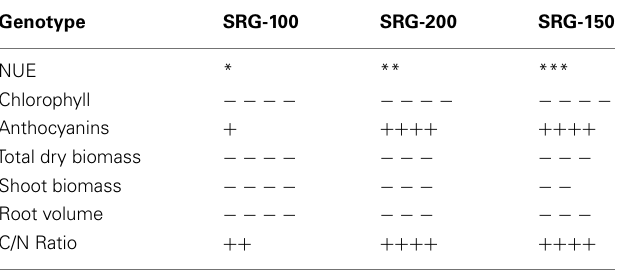
Table 3 | Summary of the relative gene expression level of N and C metabolism genes in the three genotypes growing under N limitation, the number of positive or negative indicates the higher or lower level of the trait relative to the SRG-100